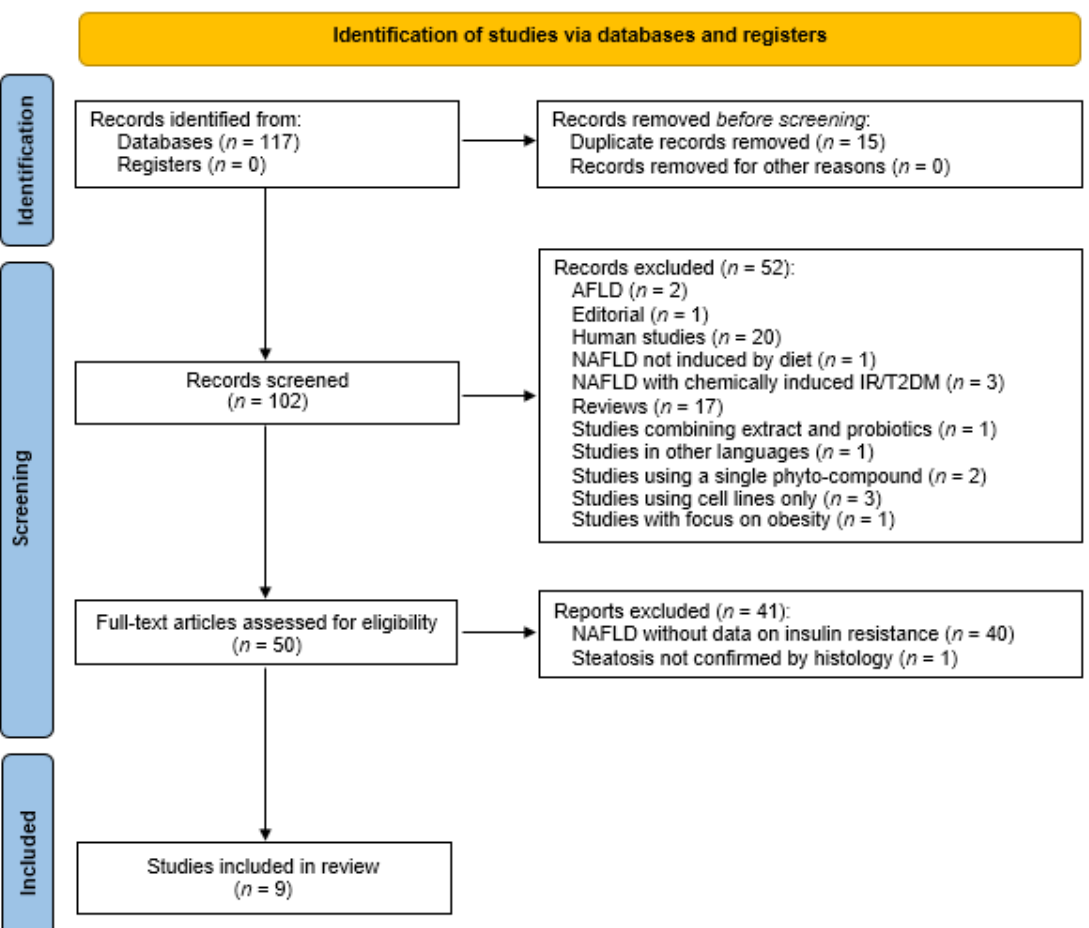
Figure 2. Flowchart depicting the screening and selection of studies included in the systematic review in accordance with the preferred reporting items for systematic reviews and meta-analyses (PRISMA) statement [31]. NAFLD, non-alcoholic fatty liver disease; AFLD, alcoholic fatty liver disease; IR, insulin resistance; T2DM, type-2 diabetes mellitus.